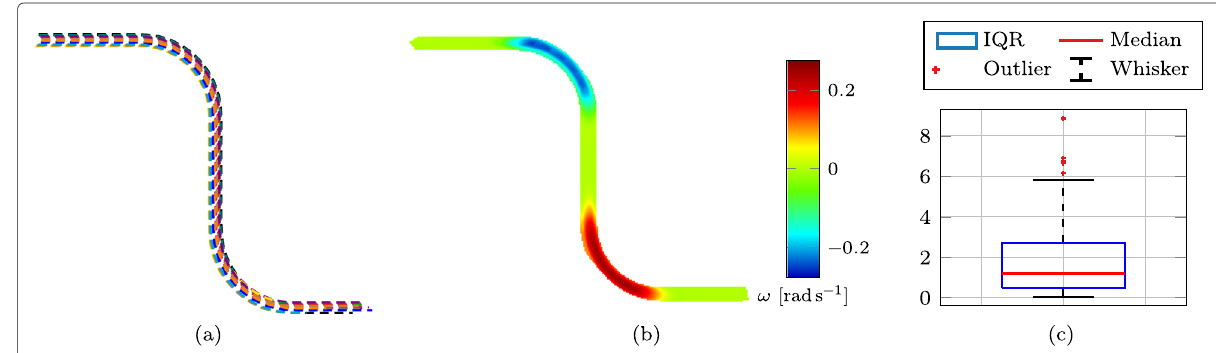
Fig. 5 a True example trajectories. b Actual turn rates in the environment used in the simulations presented in the following section. At the top turning point of the environment, the turn rate is negative, while it is positive at the bottom turning point. In between, i.e., in the nearly straight section, the turn rate is almost zero. c Illustrative boxplot of the exponential distribution E ( 2